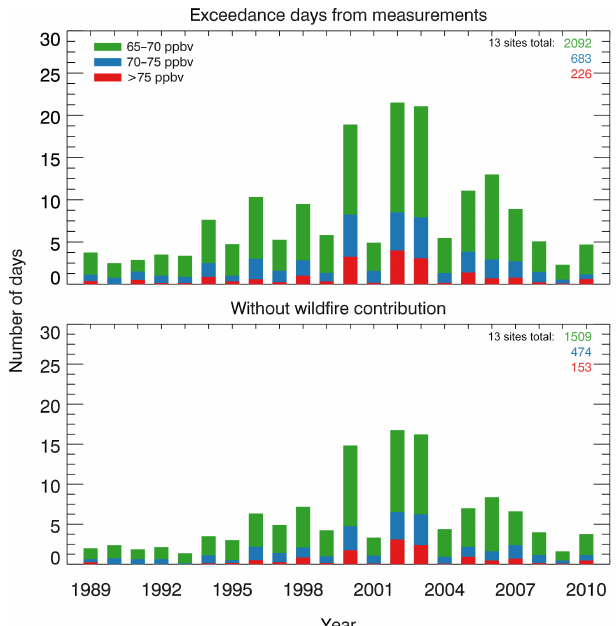
Figure 9. Mean number of days with MDA8 ozone concentra- tions exceeding the thresholds of 65, 70, and 75ppbv averaged over the 13 CASTNet sites in the Intermountain West for the summers 1989–2010. The top panel shows the exceedances computed from the measurements, and the bottom panel shows results that would be presented in the absence of wildfires (measurements minus the MLR estimated wildfire ozone